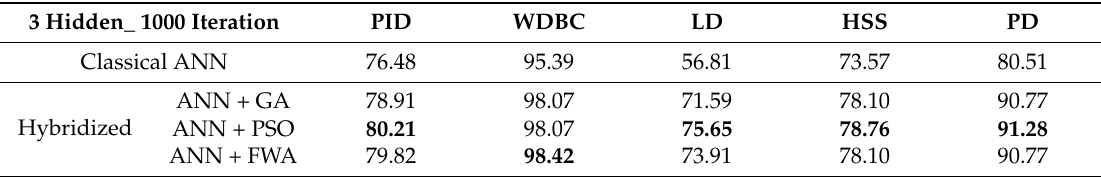
Table 5. Three-hidden-layer ANN hybridized with optimization algorithms GA, PSO, and FWA for 1000 iterations.